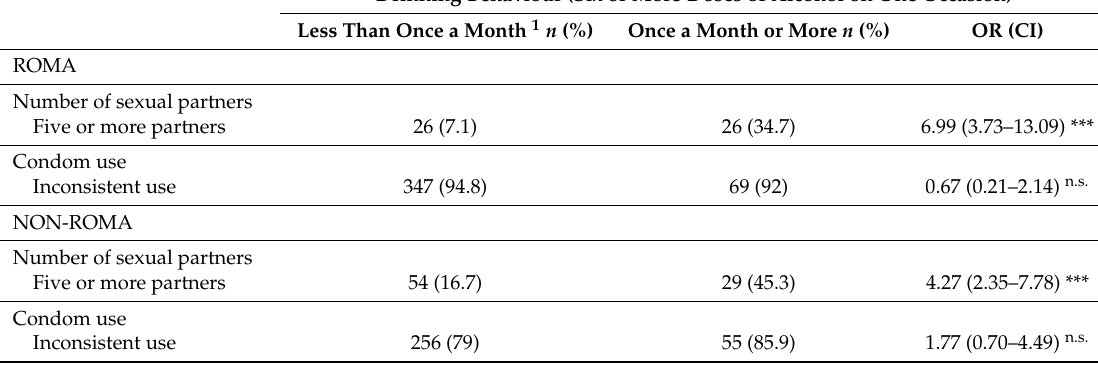
Table 3. Sexual and drinking behaviour of the population living in Roma settlements and the non-Roma population in eastern Slovakia (logistic regression model, odds ratios and 95% confidence